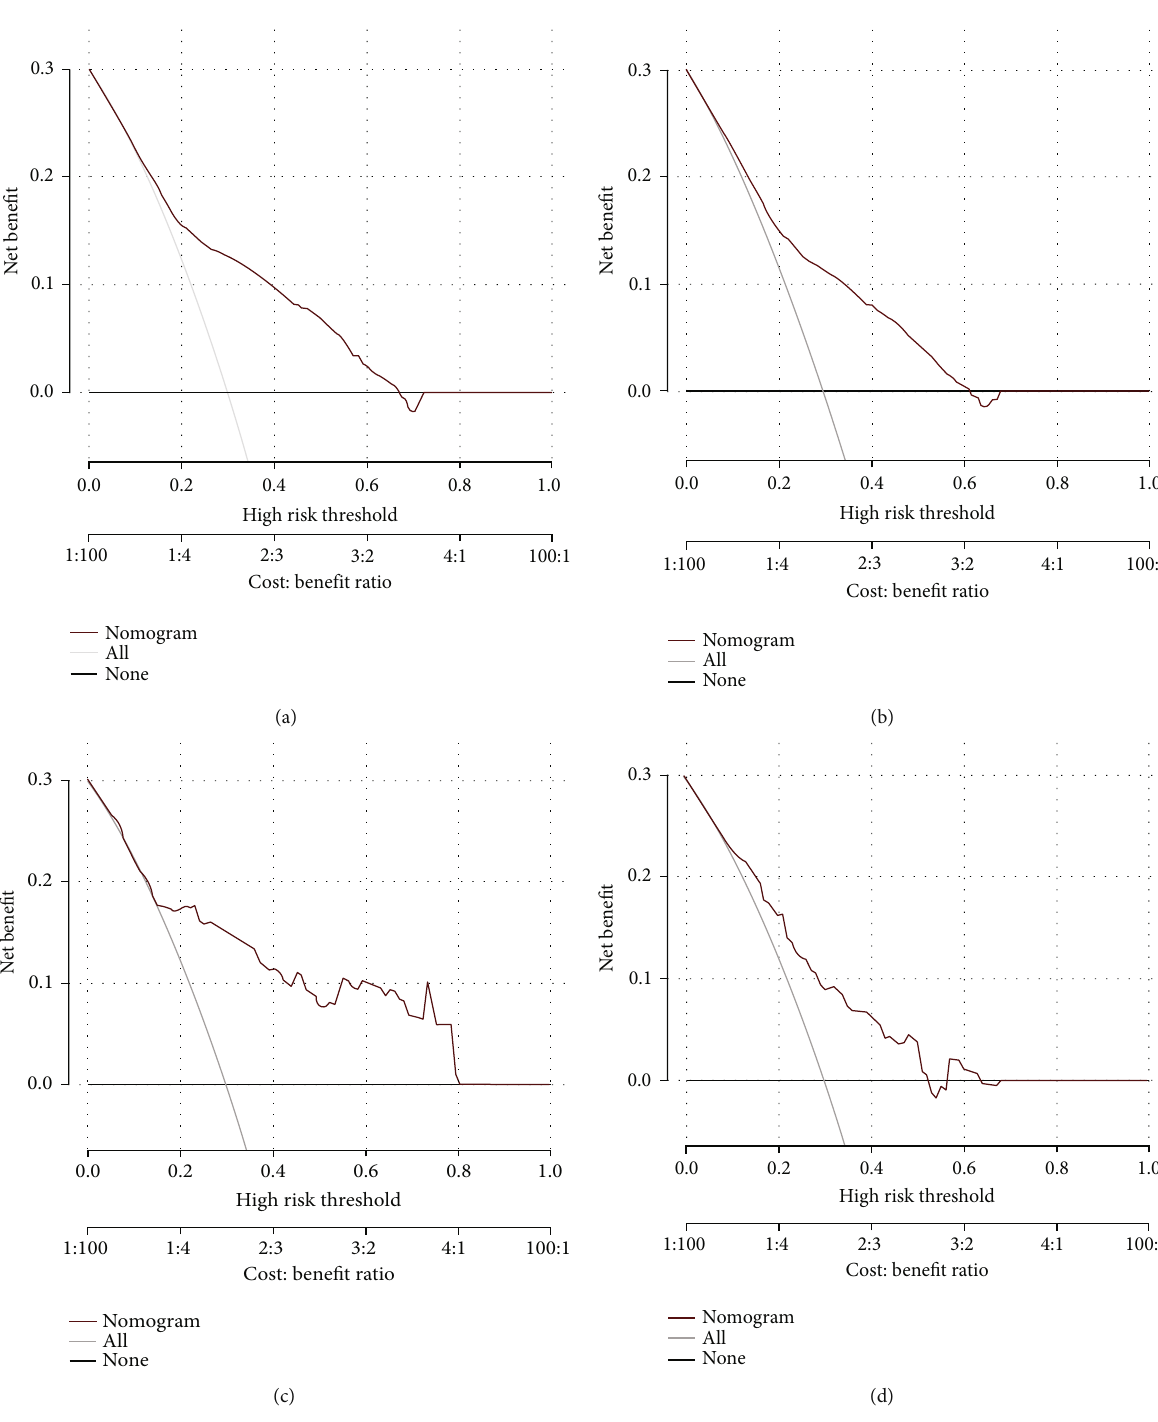
Figure 4: The decision curve analysis (DCA) for the nomogram of overall early death (a) and speci fi c early death (b) in the SEER database. The decision curve analysis (DCA) for the nomogram of overall early death (c) and speci fi c early death nomogram (d) in the validation